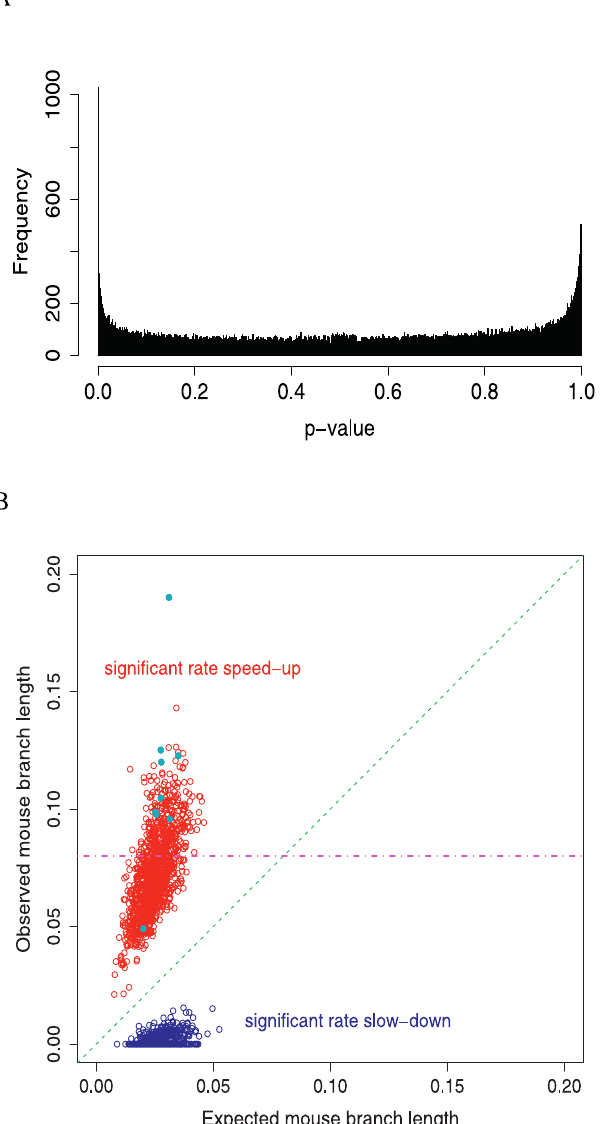
Figure 4. Excess of Significant Mammalian CNCs on the Mouse Lineage (A) Histogram of p -values of SRT m . The peaks on the left and the right indicate an excess of CNCs that are fast and slow evolving in mice, respectively. (B) Observed and expected branch lengths (per site) of mammalian CNCs that are significant on the mouse lineage at p , 0.001. Fast- and slow- evolving CNCs are indicated in red and blue, respectively. The violet dashed horizontal line shows the genome-wide average substitution rate on the mouse lineage for unconstrained regions near the fast-evolving CNCs (see text). Nine CNCs that have evolved significantly faster than their local neutral rates on the mouse lineage ( p , 0.05) are indicated by light blue